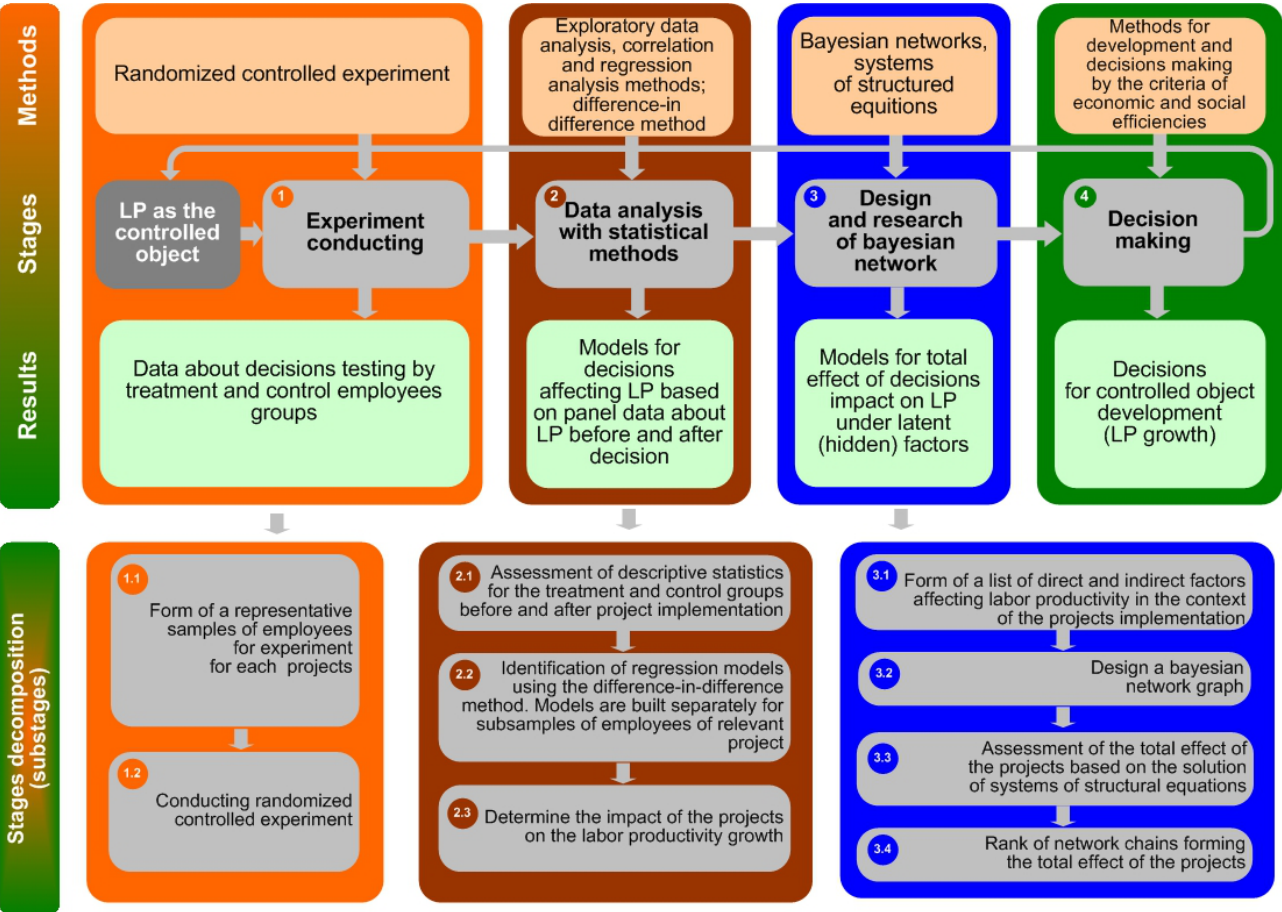
Figure 1. Technology for labor productivity (LP) modeling and management based on the causal relations.